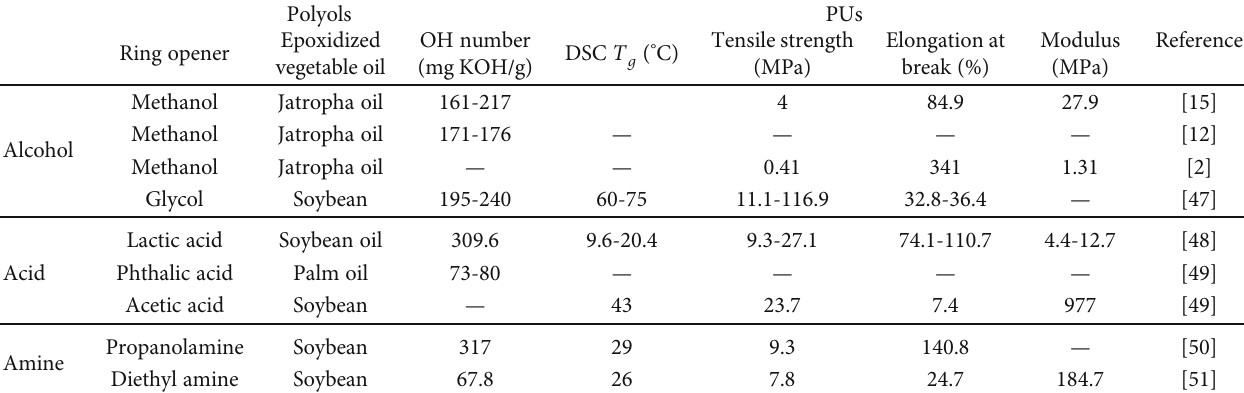
Table 3: Mechanical and thermal properties of vegetable-based polyol polyurethane synthesized via epoxidation and ring-opening.